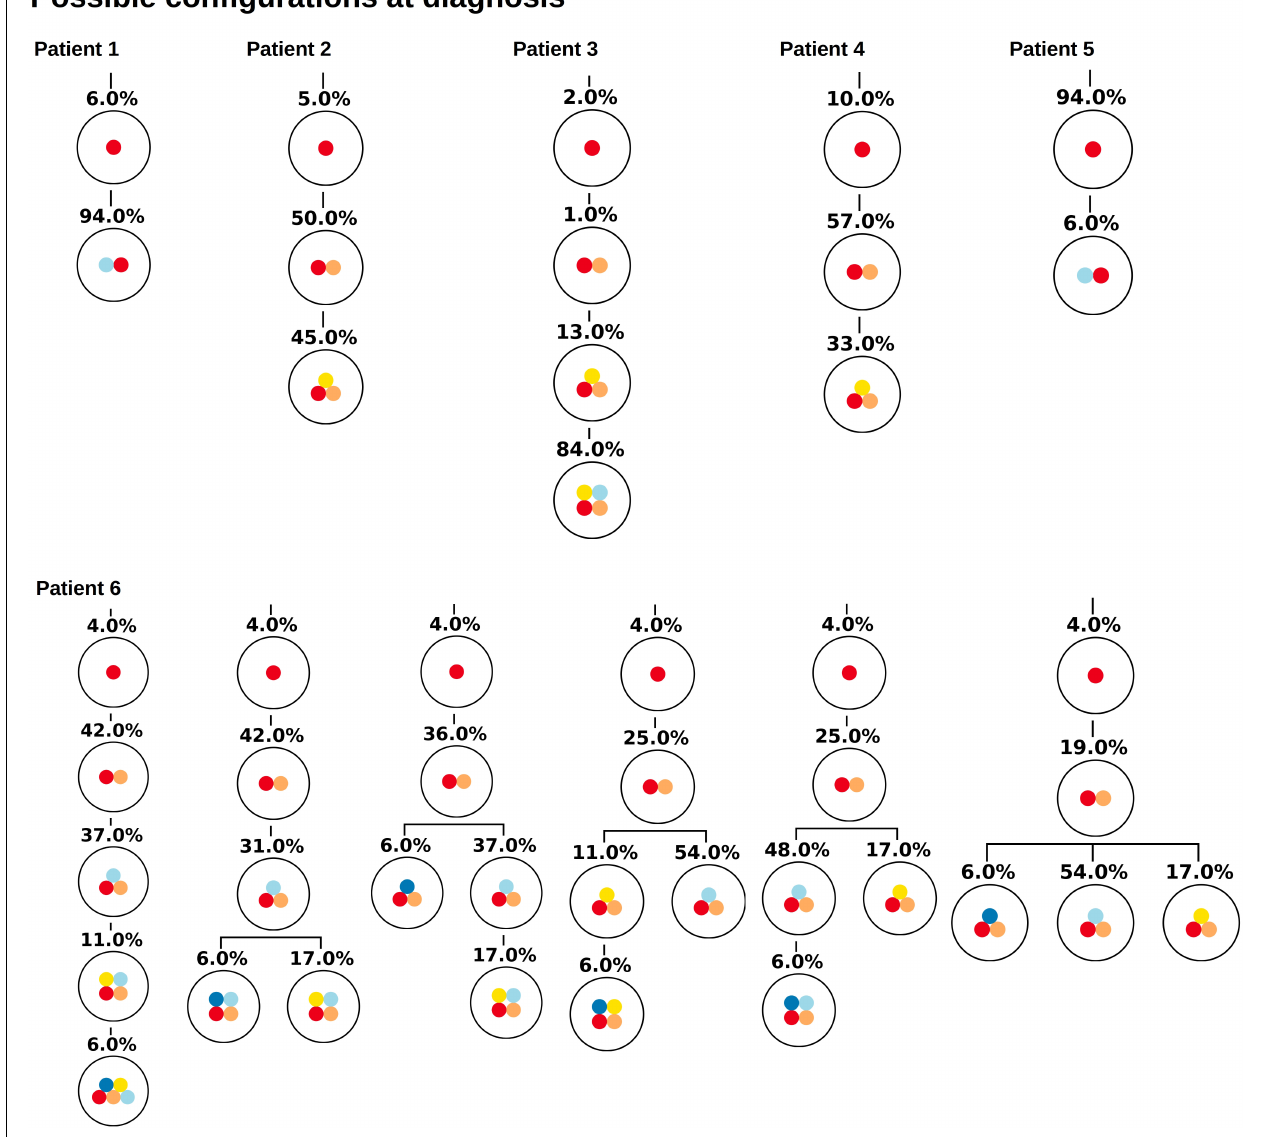
FIGURE 2 | Clonal hierarchies compatible with the bulk allele frequencies measured at diagnosis. For each considered patient all clonal hierarchies are depicted that are compatible with the bulk variant allele frequencies measured at diagnosis. The root of the tree corresponds to the founder mutation that is present in all leukemic cells. The percentages indicate the frequencies of the respective clones that have to be mixed to obtain the measured bulk VAF. We observe that in most cases the hierarchies are